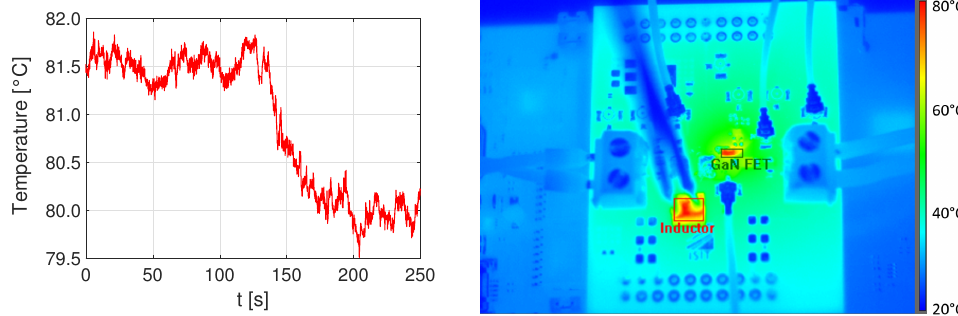
Figure 15. Temperature curve ( left ) and thermal image during active cooling ( right